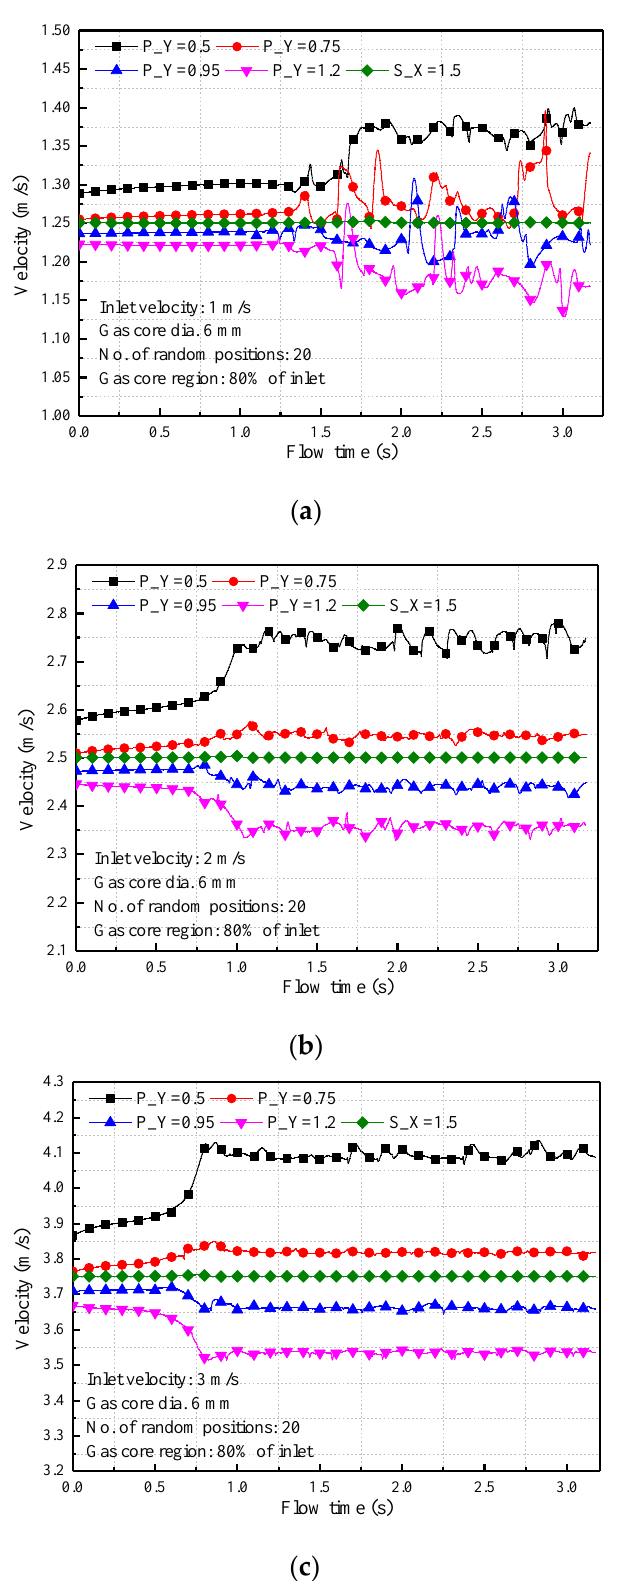
Figure 9. Effect of the inlet gas–liquid bubbly velocity on flow instability for various inlet velocities: ( a ) inlet velocity, v = 1 m s − 1 ; ( b ) inlet velocity, v = 2 m s − 1 ; ( c ) inlet velocity, v = 3 m s − 1 .